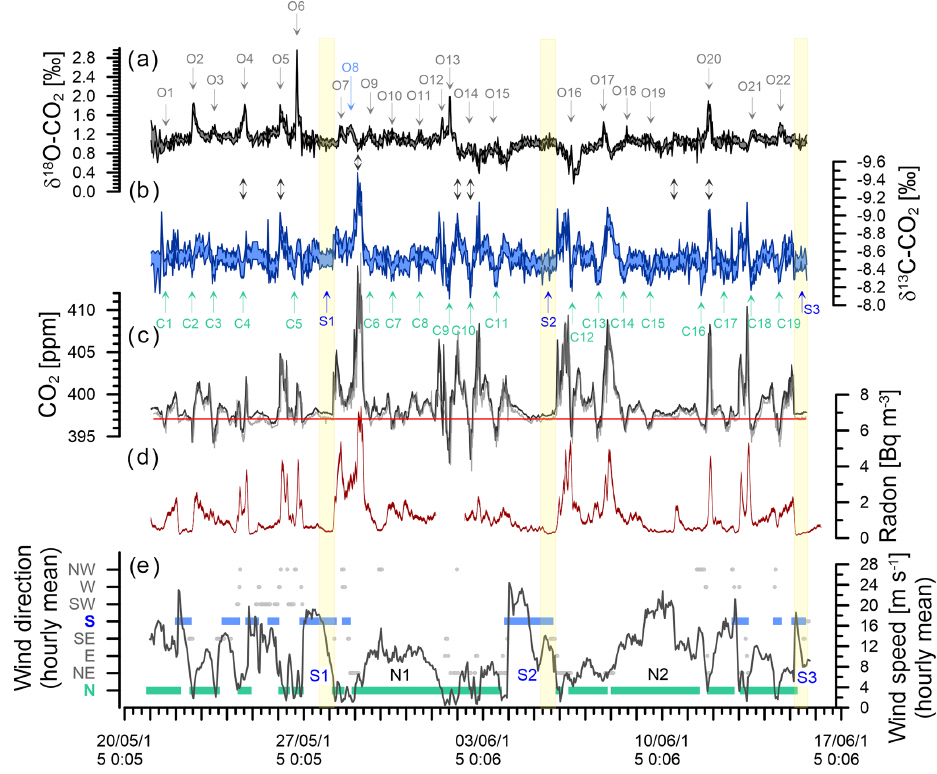
Figure 6. Observations during the deployment at BHD (Sperlich et al., 2022). Delta Ray time series of δ 18 O-CO 2 (a) and δ 13 C-CO 2 with inverted y axis (b) . CO 2 mole fractions measured with Delta Ray (black) and Siemens (grey) with the average of the Siemens analyser for baseline CO 2 measured during S2 indicated in red (c) . Coloured shading in panels (a) , (b) and (c) indicates the standard deviation of the measurement averages of the Delta Ray measurements. Events in the δ 18 O-CO 2 and δ 13 C-CO 2 time series are numbered from O1 to O22 and C1 to C19, respectively. Panel (d) shows the radon time series and panel (e) hourly averages of meteorological data. Southerly and northerly wind events are highlighted in blue and green, respectively. Wind speed is displayed by the black line. The yellow boxes highlight the most stable periods of the three significant southerly events S1, S2 and